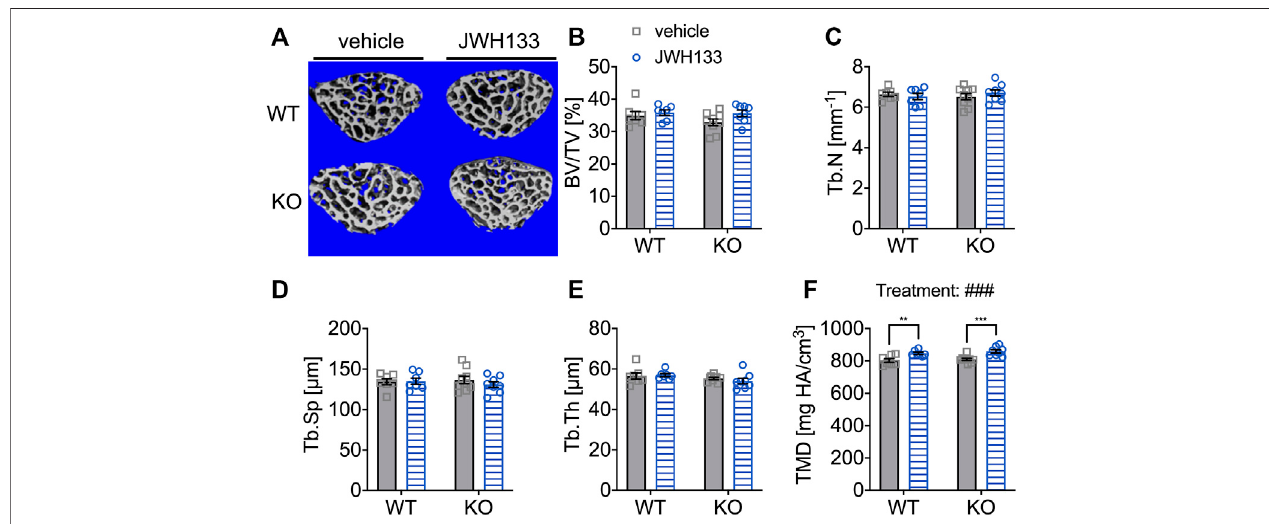
FIGURE7| ProlongedtreatmentwithJWH133 increasedtissue mineraldensity inthevertebraeofaged mice. (A) Representativeimage ofthevertebraltrabecular bone compartment (L5) analyzed by μ CT of p62 KO and WT mice treated with vehicle or JWH133. (B) Bone volume per tissue volume (BV/TV) was similar between WT and p62 KO mice showed no effect of treatment. (C) Trabecular number (Tb.N) was comparable between genotypes showed no effect of treatment. (D) Trabecular spacing (Tb.Sp) showed no difference between genotype or treatment. (E) Trabecular thickness (Tb.Th) was not different. (F) Tissue mineral density (TMD) was signi fi cantly in fl uenced by the treatment with JWH133 and affected p62 KO and WT mice. Data were analyzed by using ordinary two-way ANOVA and Bonferroni adjusted p values,* p < 0.05,** p < 0.01,*** p < 0.001.Allerrorbarsshowmean±SEM.Squaresandcirclesrepresentindividualdatapoints.WTvehicle N =7,KOvehicle